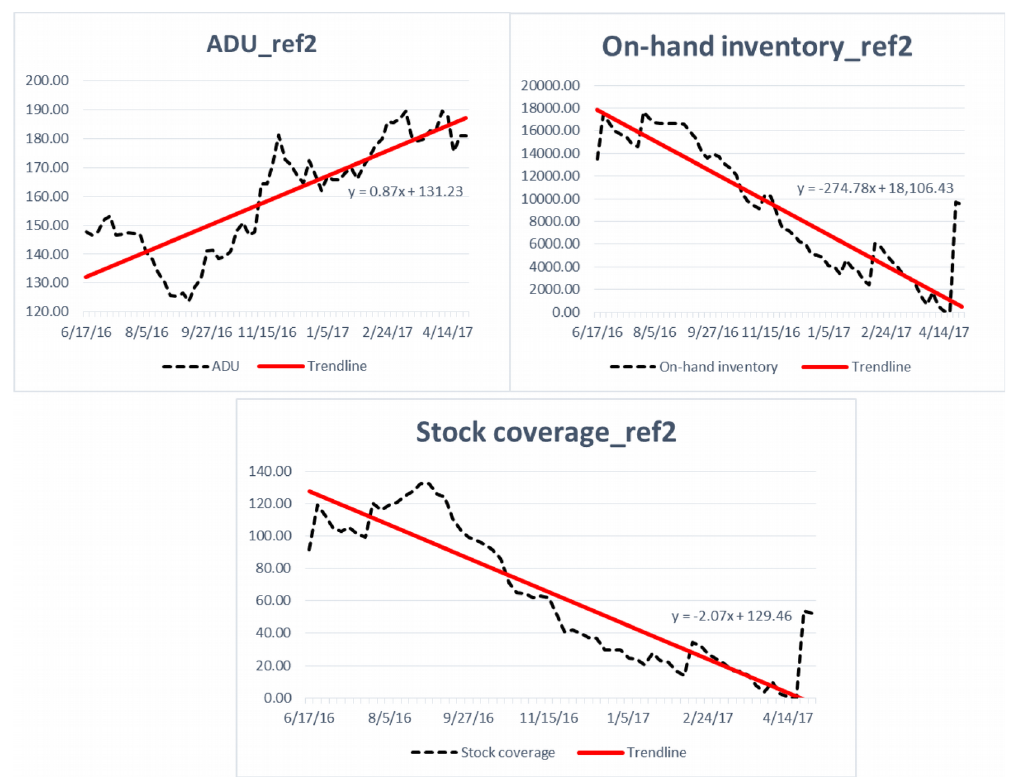
Figure 13. (a) the ADU, (b) on-hand inventory and (c) stock coverage of Ref2 of the analyzed